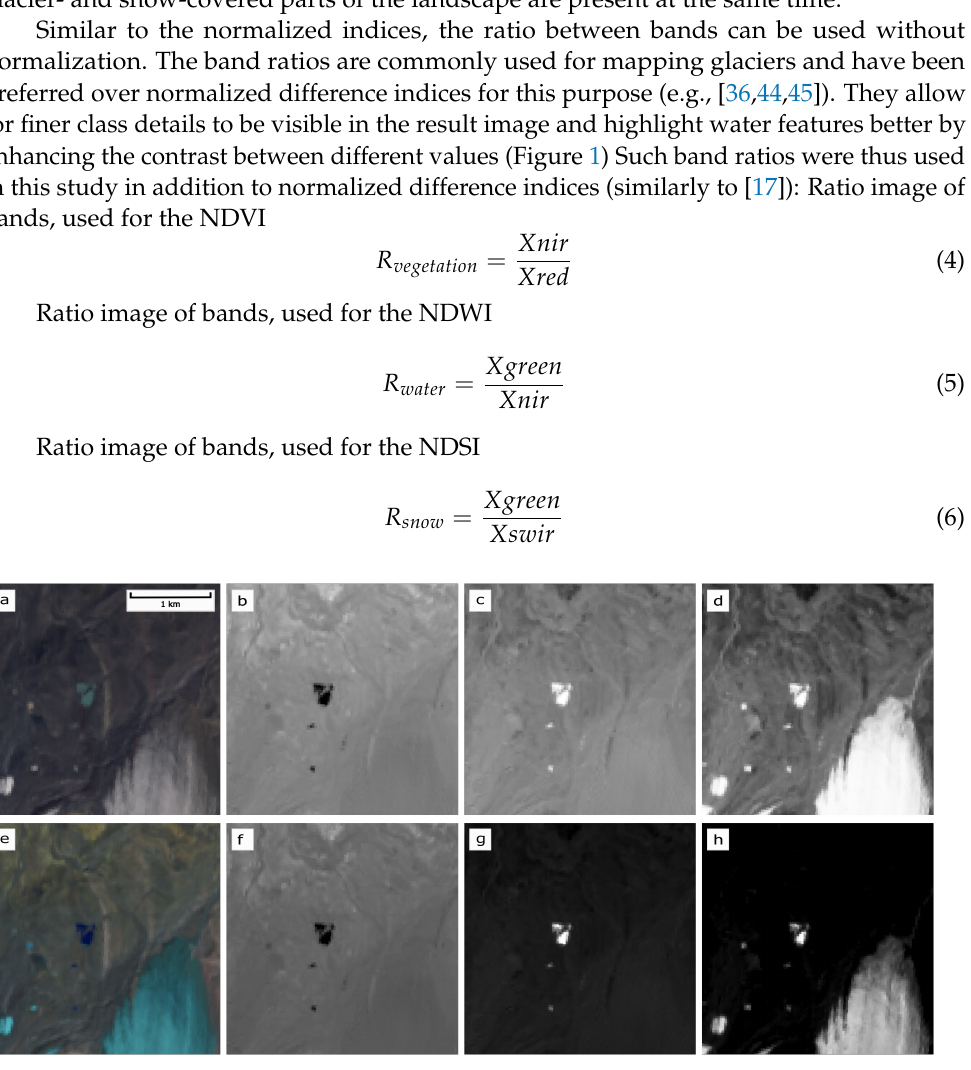
Figure 1. Examples of spectral indices and ratios (Landsat 8 image from 26/08/2020; Mount Elbrus, Central Caucasus). ( a ) Natural Color Composite (Red-Green-Blue), ( b ) NDVI, ( c ) NDWI, ( d ) NDSI, ( e ) False Color Composite (SWIR-NIR-Red), ( f ) NIR/Red ratio, ( g ) Green/NIR ratio, ( h ) Green/SWIR